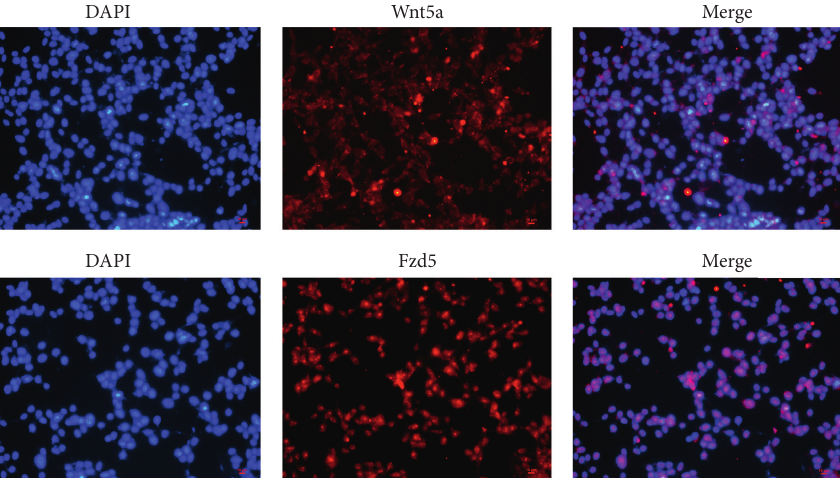
Figure 4: Expression of Wnt5a and Fzd5 in the Min6 cells. Immunofluorescence staining of Min6 cells for Wnt5a and Fzd5 (scale bar � 10 μ